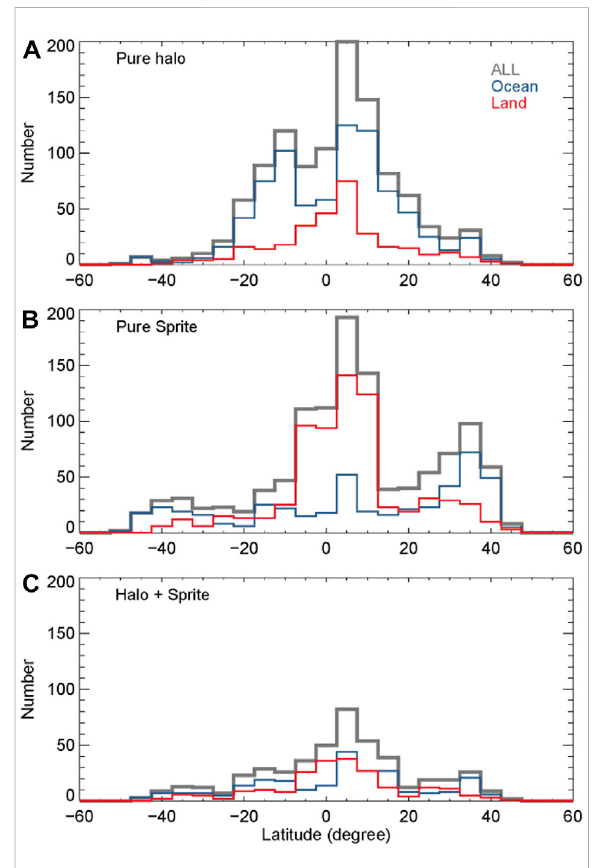
FIGURE 2 Distribution of ISUAL-observed TLEs along latitudes. The ISUAL TLEs are classi fi ed into three categories, i.e., (A) pure halo, (B) pure sprite, and (C) halo with